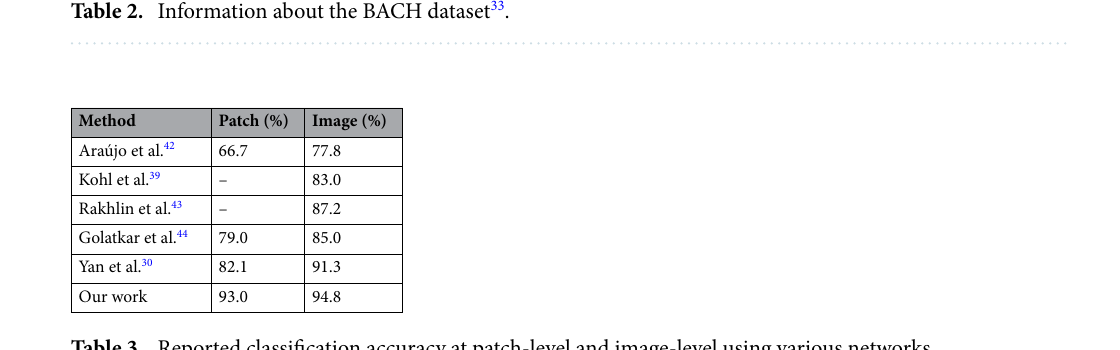
Table 2. Information about the BACH dataset 33 .